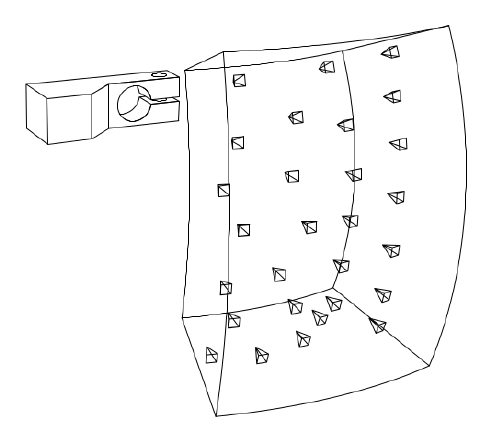
Figure 4. Several model views from different camera positions and orientations in a user-specified area pointing to the origin of the object (Ulrich et al.,